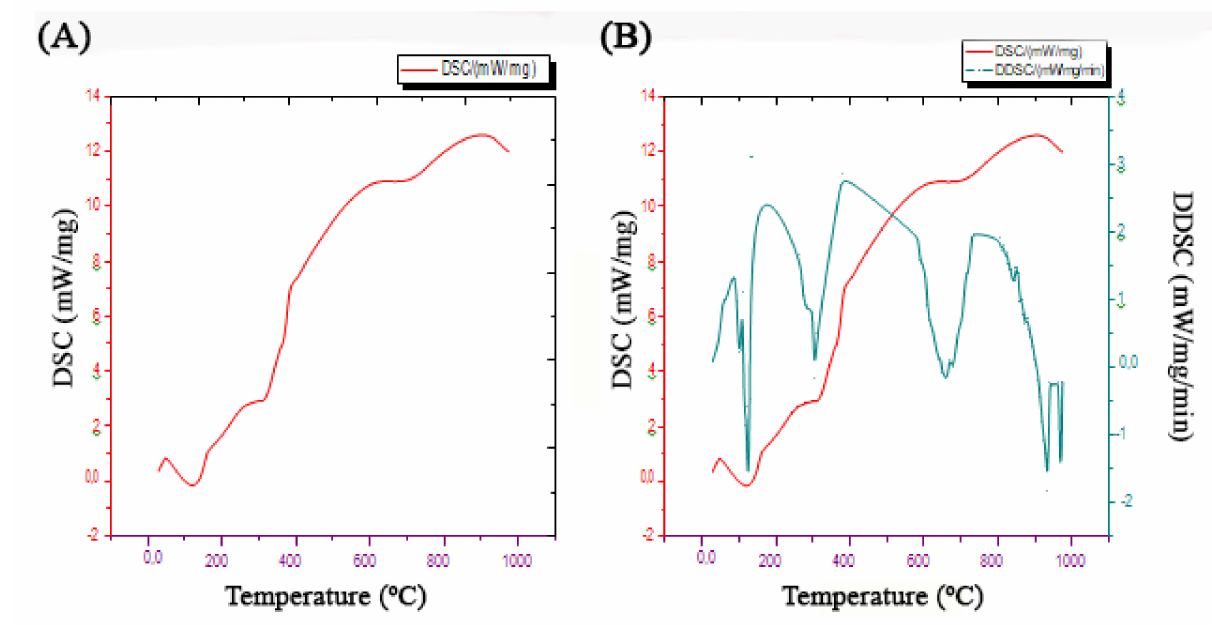
Figure 8. DSC ( A ) and DDSC ( B ) curves for piperine crystal